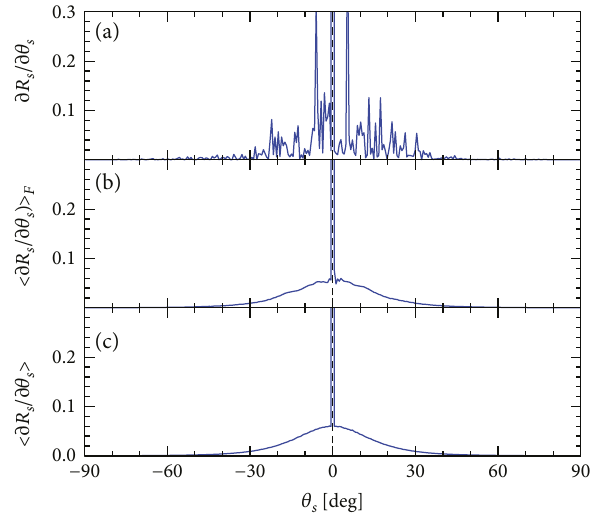
Figure 3: Same as Figure 2 but for s-polarized incident beams, / ∂ θ de fi ned by p s the single realization of the rough interface used to obtain the results of the fi rst two panels of this fi gure is the same one used in Figure 2. and 0 =2 π c/ 0